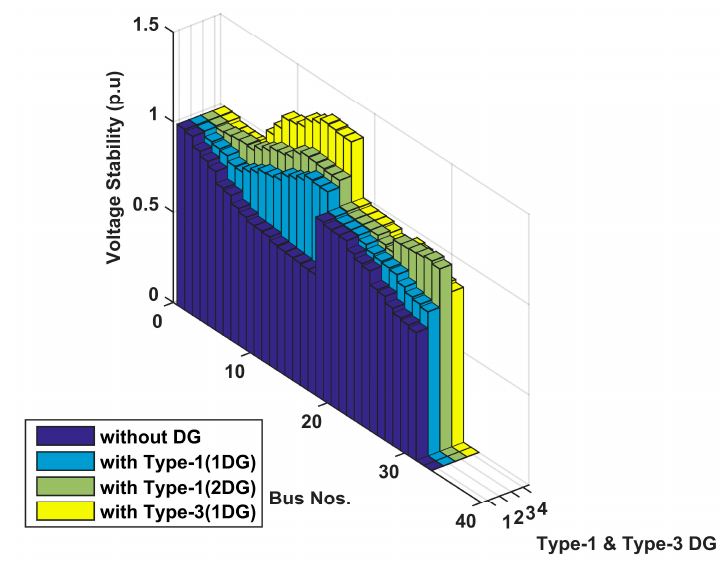
Figure 12. Voltage stability for 33 bus with Type-1 (1 DG and 2 DG) and Type-3 (1 DG) for 2nd objective function.